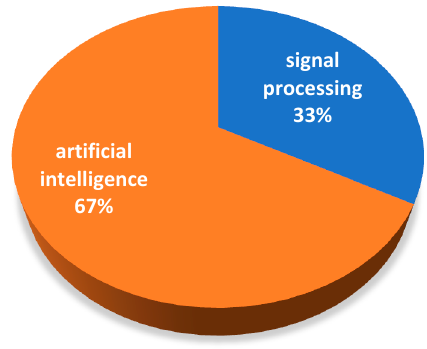
Figure 7. The ratio of signal processing to artificial intelligence.